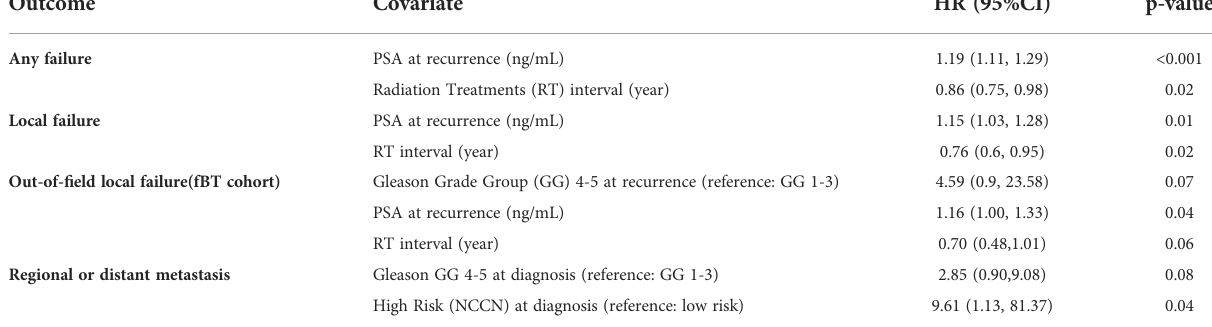
TABLE 2 Univariate analysis of predictive factors of